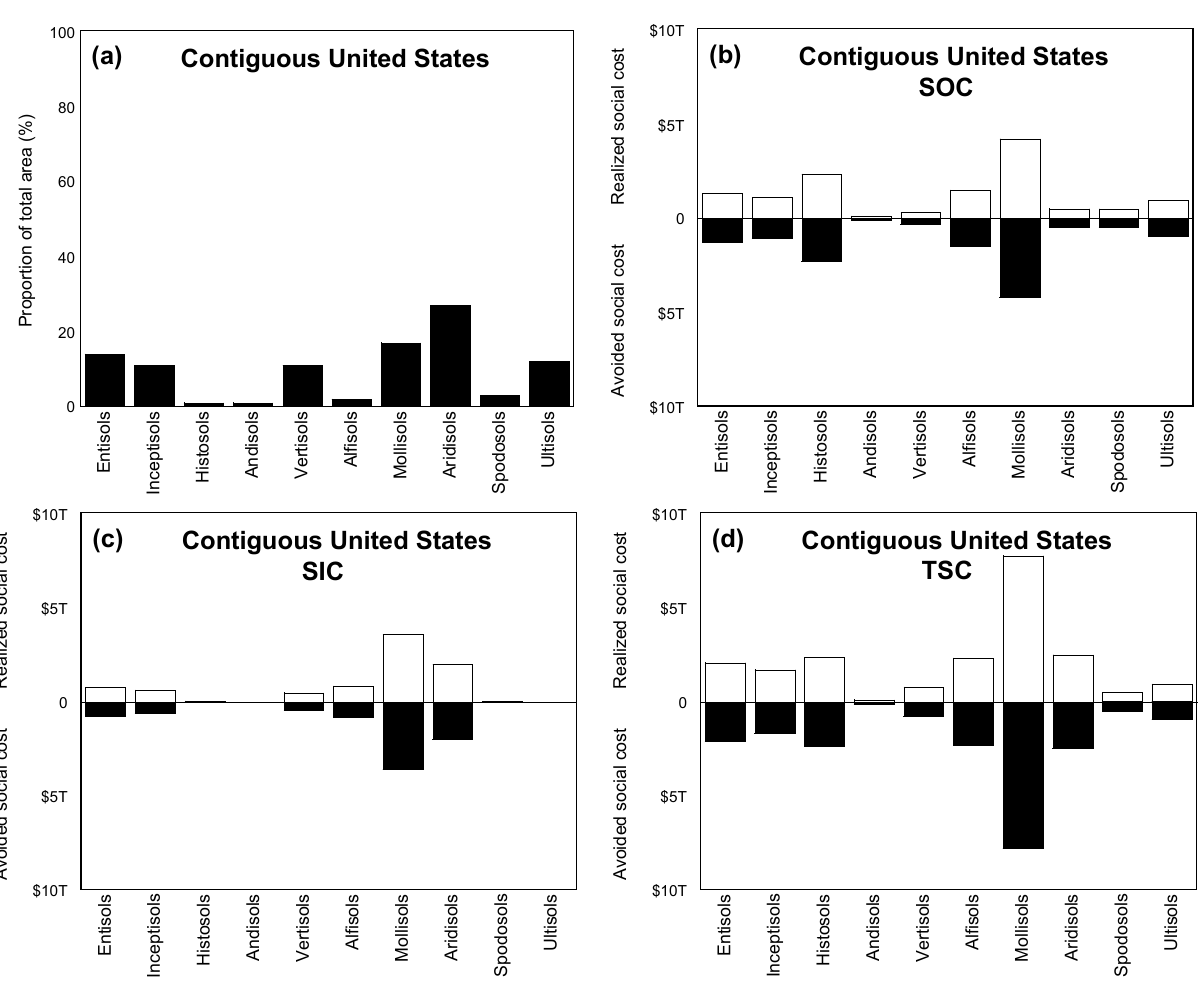
Figure 11. Diagram showing how “portfolio effect” and “distribution effect” of pedodiversity can vary within the country: ( a ) pedodiversity by soil order area; ( b ) value of soil organic carbon (SOC) storage, ( c ) value of soil inorganic carbon (SIC) storage, ( d ) value of total soil carbon (TSC) storage in the upper 2 m depth based on avoided or realized social cost of CO 2 (SC-CO 2 ) of $42 (USD) per metric ton of CO 2 [30,35,36,51] by soil order. Note: T = trillion = 10 12